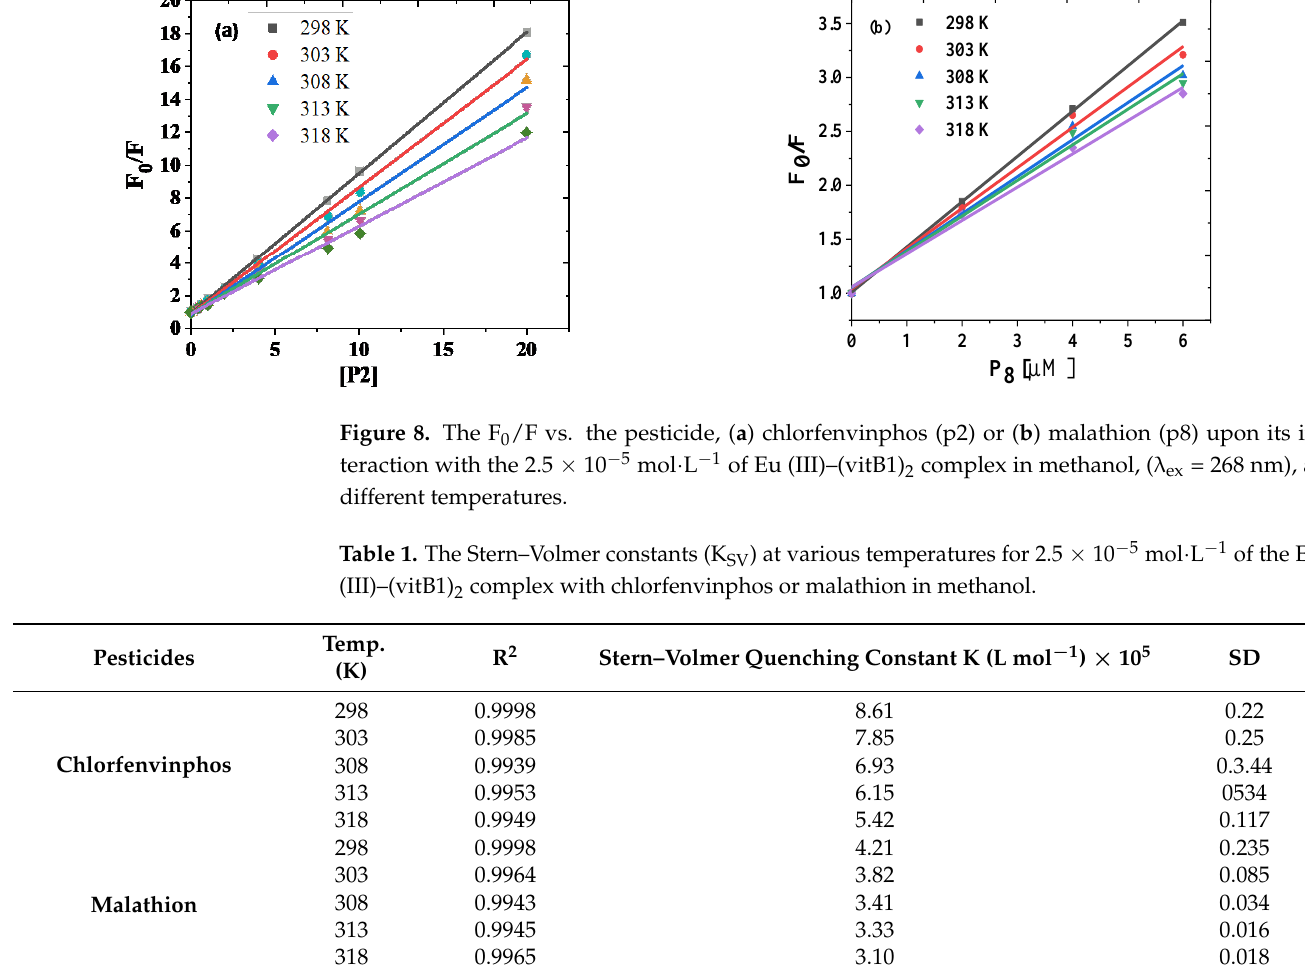
Table 1. The Stern – Volmer constants (K SV ) at various temperatures for 2.5 × 10 −5 mol. L −1 of the Eu (III) – (vitB1) 2 complex with chlorfenvinphos or malathion in methanol. Temp. Pesticides